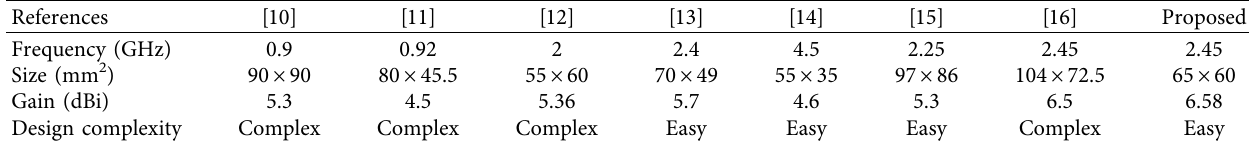
Table 2: Comparison of the proposed quasi-Yagi antenna with other quasi-Yagi